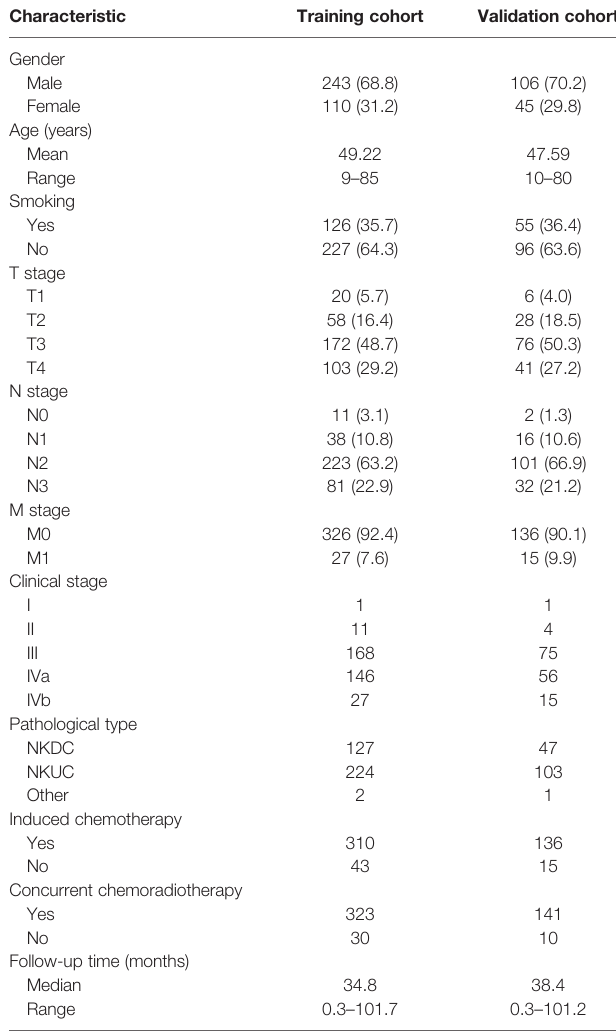
TABLE 1 | Demographic and clinical characteristics of patients with NPC in the training cohort and validation cohort.